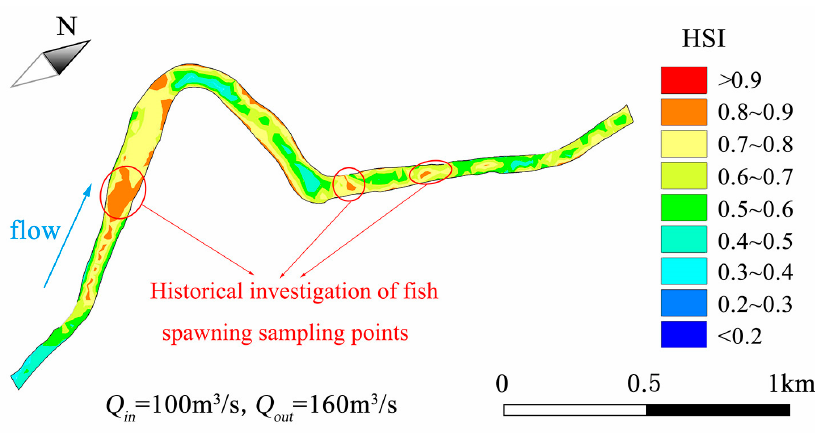
Figure 15. The main distribution area of C. idella spawning.